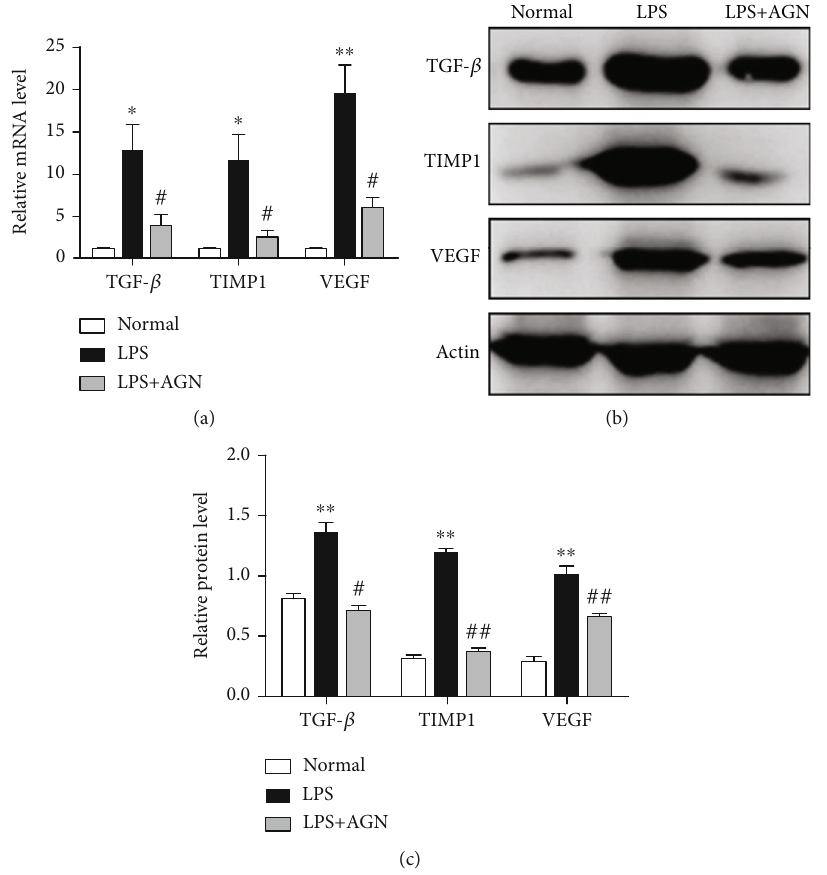
Figure 5: Agnuside downregulates fi brosis marker expression in LPS-treated FLSs. (a) Relative mRNA levels of TGF- β , TIMP1, and VEGF in FLSs in each group. ∗ P < 0 : 05 , ∗∗ P < 0 : 01 , in comparison with the normal group. # P < 0 : 05 , in comparison with the KOA group. (b) Typical protein bands for each group. (c) Comparison of TGF- β , TIMP1, and VEGF protein expressions between groups. ∗∗ P < 0 : 01 , compared with the normal group. # P < 0 : 05 , ## P < 0 : 01 , compared with the KOA